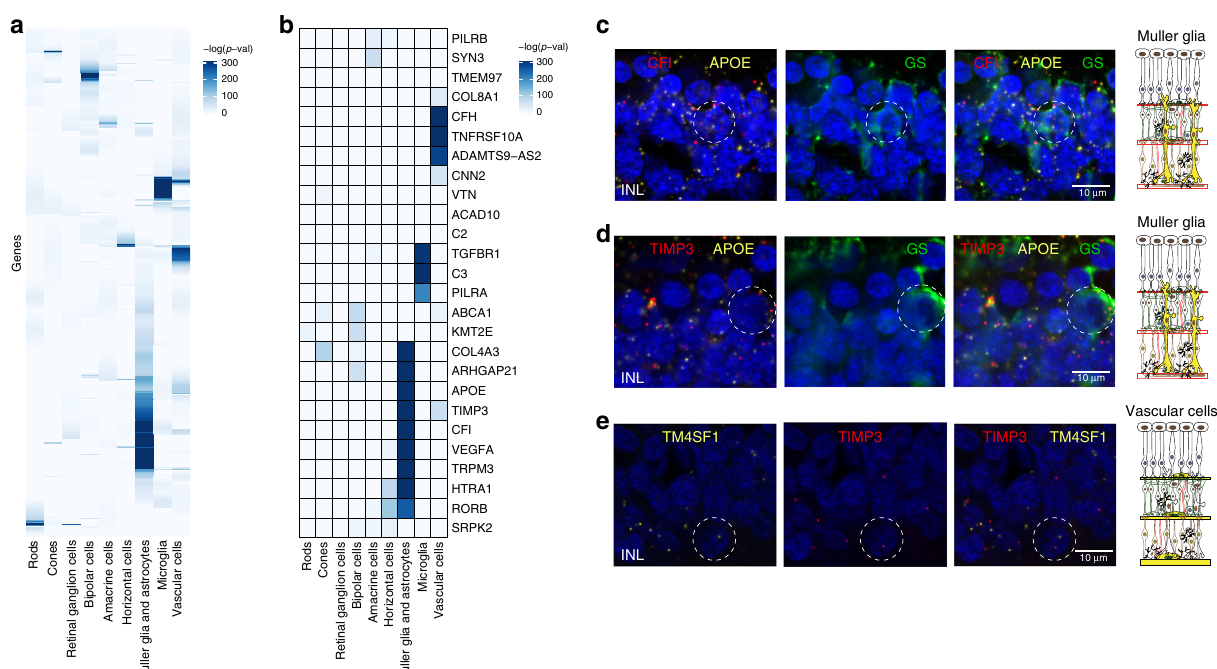
Fig. 4 Cell-type speci fi city of AMD-associated genes using micro fl uidics scRNA-seq. a Gene expression speci fi city of 585 genes previously associated with the 34 AMD locus regions de fi ned by the 52 identi fi ed variants and their proxies ( r 2 ≥ 0.5, ±500 kb), reported in Fritsche et al. 37 . Speci fi city scores are computed using one-sided Wilcoxon rank-sum test, and reported as the log-transformed value of the adjusted p -values. b Gene expression enrichment scores for the leading AMD genes, de fi ned for each locus as the gene nearest to the lead variant (variant with smallest P value), as reported in Fritsche et al. 37 . c – e Expression pattern of AMD risk alleles CFI and TIMP3 in the human retina. Representative images of multiplex in situ hybridization with immuno fl uorescence of c APOE (labeled in yellow, identi fi es Müller glia), CFI (labeled in red) and glutamine synthetase (GS, identi fi ed in green); d APOE (labeled in yellow, identi fi es Müller glia), TIMP3 (labeled in red) and glutamine synthetase (GS, identi fi ed in green), and e TM4SF1 (labeled in yellow, identi fi es vascular endothelium) and TIMP3 (labeled in red). White dotted circles indicate double positive cells. Data are representative of three independent